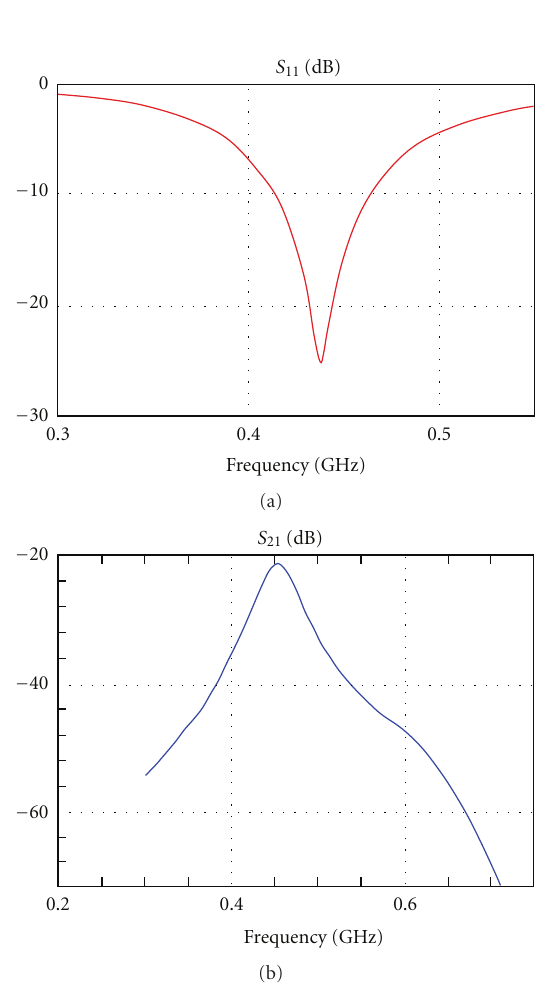
Figure 10: Measured scattering parameter of the antenna deep in tissue-equivalent liquid